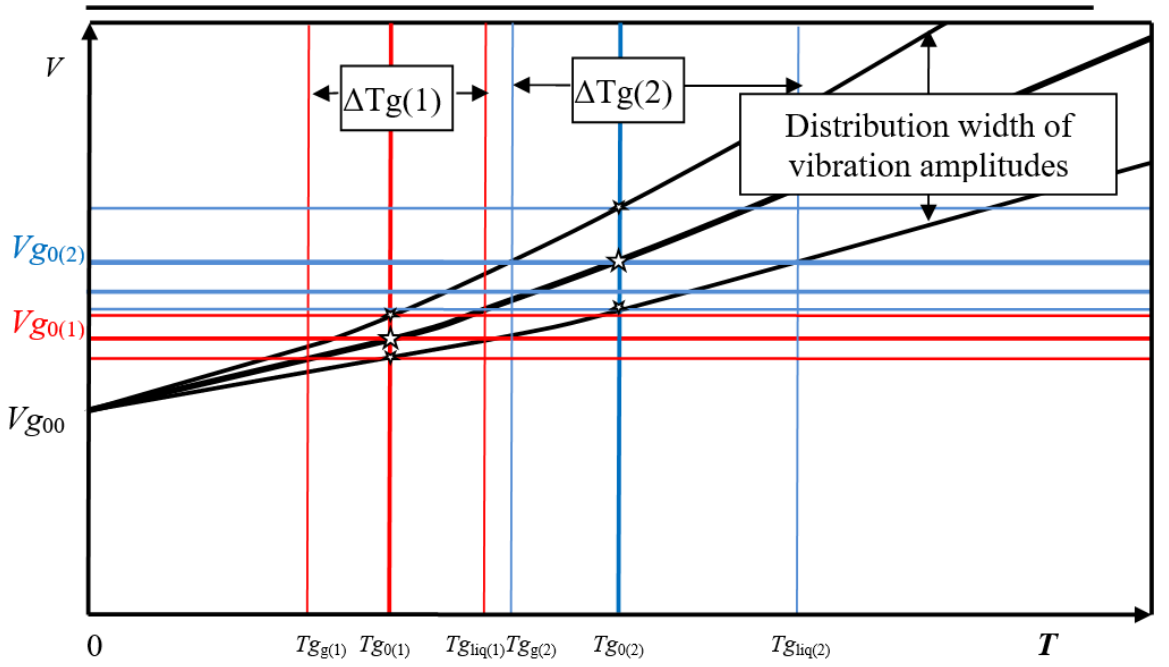
Figure 14. Width of the transformation interval in dependence of the magnitude of Tg 0 (schematic). Comparison of two different substances. The crucial quantity is Vg 0 since it is connected with molecule size and geometry. The width of the glass transition is denoted as Δ Tg.